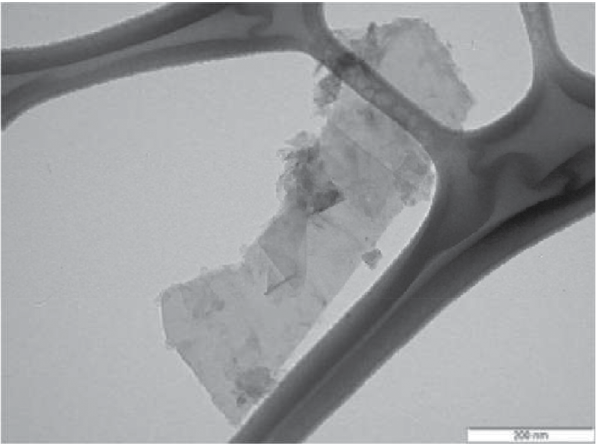
Figure 1: TEM image of GNPs [48].